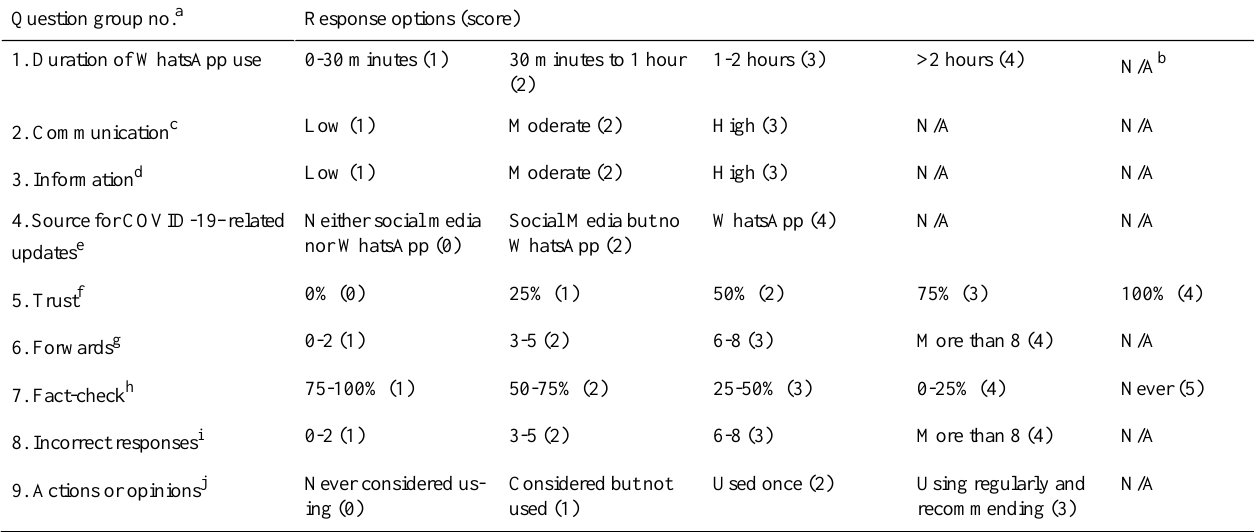
Table 1. Scoring system for calculation of K values.